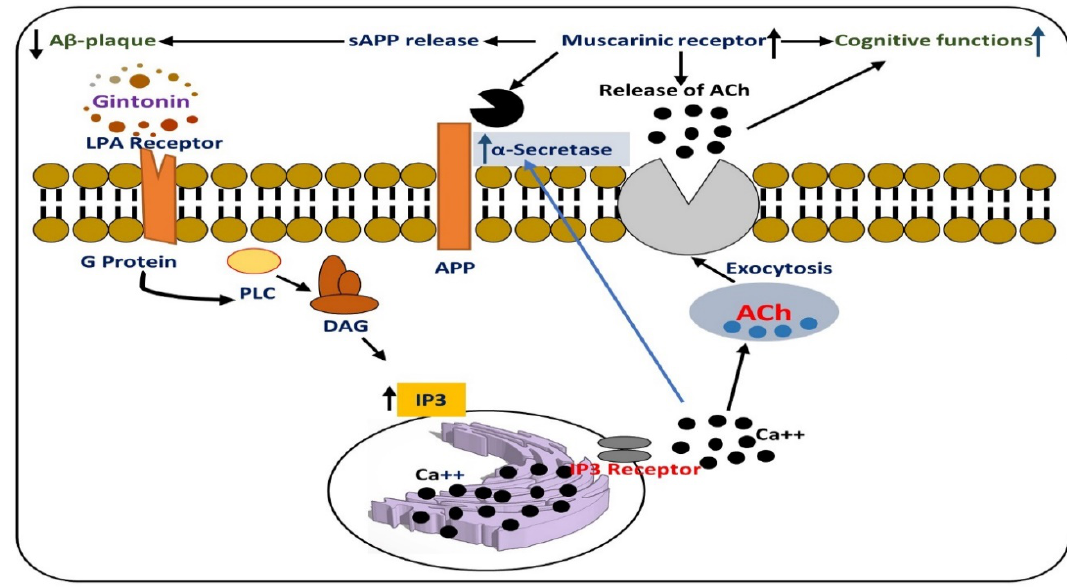
Figure 5. Graphical representation of the effects of gintonin against cholinergic dysfunction in AD models, possibly by regulating the LPA receptor. It has been suggested that gintonin mediates cholinergic systems by acetylcholine release and the increase of ChAT expression and protective effects against A β -induced and transgenic AD animal models. Gintonin-mediated activation of LPA receptors may confer neuroprotection by regulating the amyloidogenic pathway and cholinergic dysfunction in the brain. DAG: diacylglycerol, IP3: Inositol trisphosphate, LPA receptor: Lysophosphatidic acid receptors, PLC: Phospholipase C.